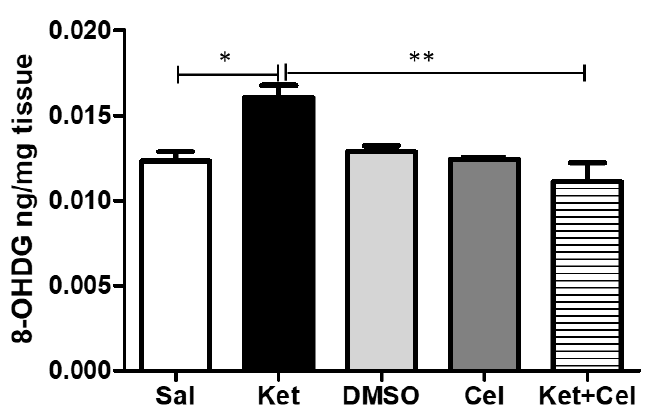
Figure 4. Celastrol administration in postnatal life prevented ketamine-induced oxidative stress in the cerebellum in later adulthood. 8-OHdG levels (ng/mg tissue) in the cerebellum of adult mice receiving saline (Sal, n = 3) or ketamine (Ket, n = 5) or a 50% DMSO in PBS (DMSO, n = 3) or celastrol (Cel, n = 3) or ketamine + celastrol (Ket + Cel, n = 5) at PNDs 7, 9 and 11. One Way ANOVA, followed by Tukey’s post hoc test F = 6.361 * p < 0.05; ** p < 0.01.